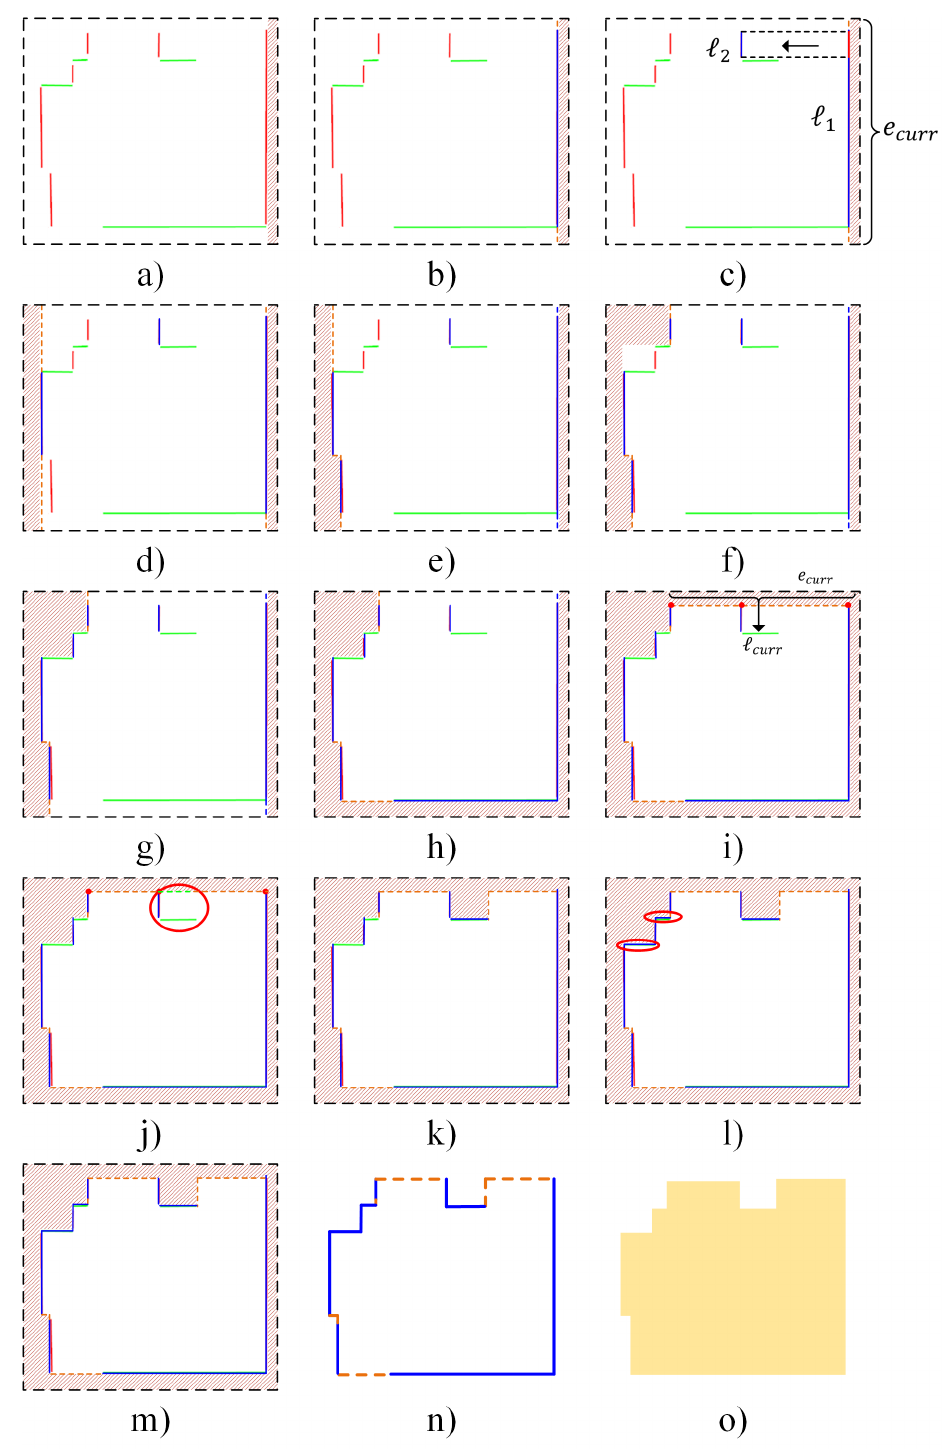
Figure 15. The process of sub-contour shrinkage: (1) ( a , b ) and ( d – h ): ordinary shrinkage situations; (2) ( c ): extra situation one; (3) ( i – l ): extra situation two (see the shrinkage strategy); (4) ( m , n ): the extracted boundary of sub-contour: orange dashed lines: the pending edges; blue lines: the determined edges; (5) ( o ): the extracted sub-contour polygon